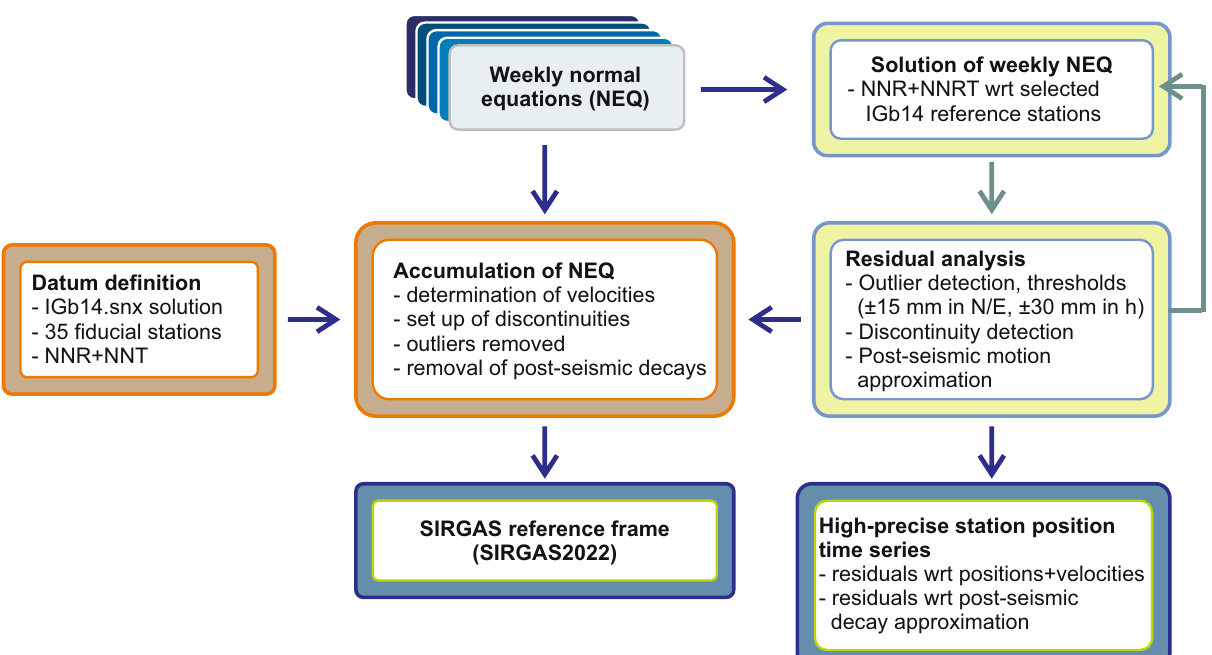
Figure 15: SIRGAS reference frame determination